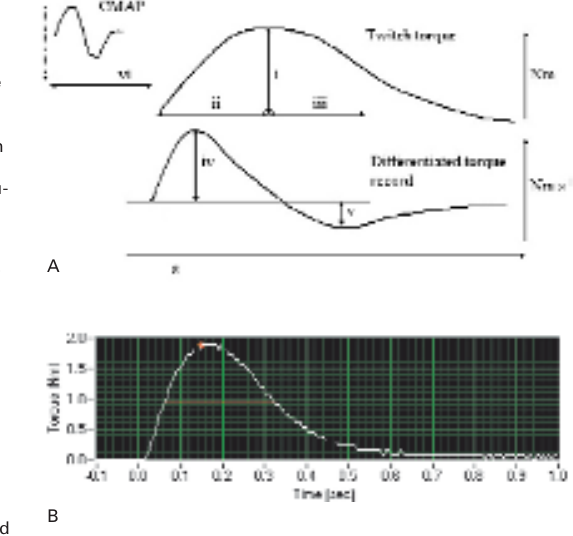
Figure 2 A Record of the twitch torque and differentiated torque of the ankle dorsi- flexor group. Com- pound muscle action potential (CMAP) is schematic; the stimu- lus is indicated by the dashed arrow.